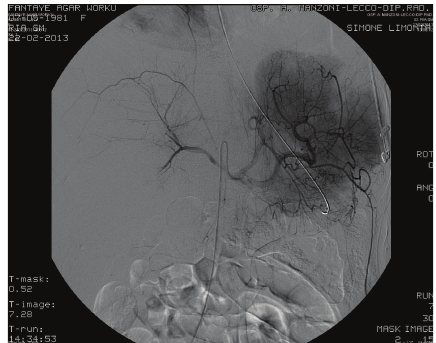
Figure 2: Superselective embolization of hepatic right